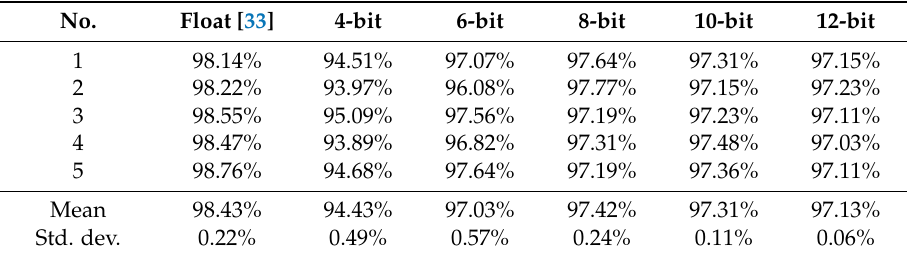
Table 4. Classification accuracies of floating-point model and quantized